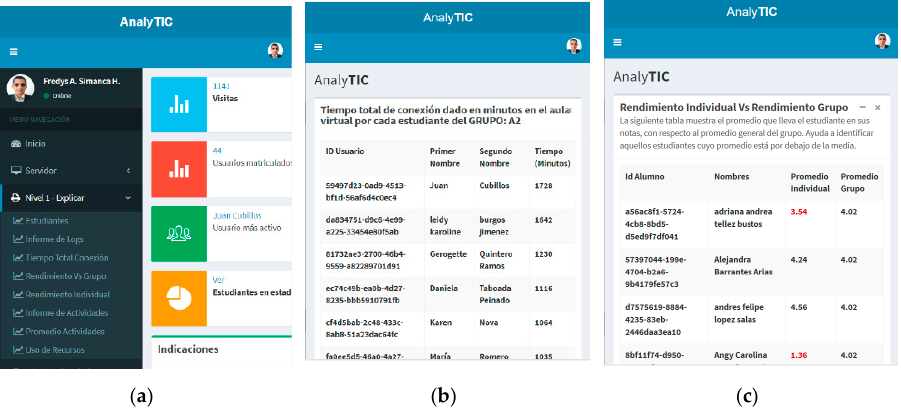
Figure 4. ( a ) First-level learning analytics (LA) options, based on data from the virtual classroom. ( b ) Detail of the total connection times for each student in the virtual classroom. ( c ) The individual performance of each student vs. the group average (an individual average in red indicates the student falls below the group